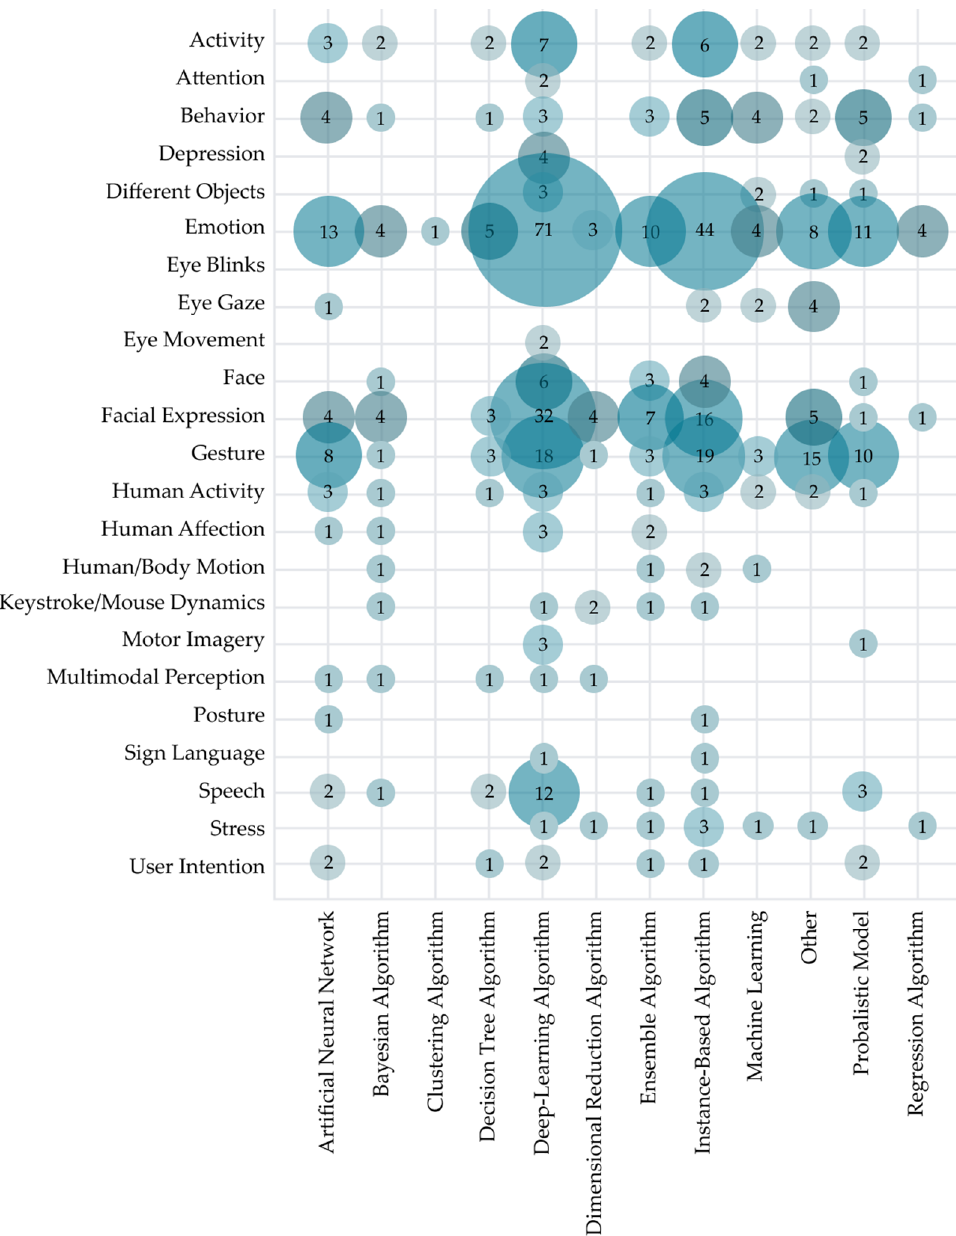
Figure 17. Distribution of AI methods and algorithms for HCI recognition solutions.